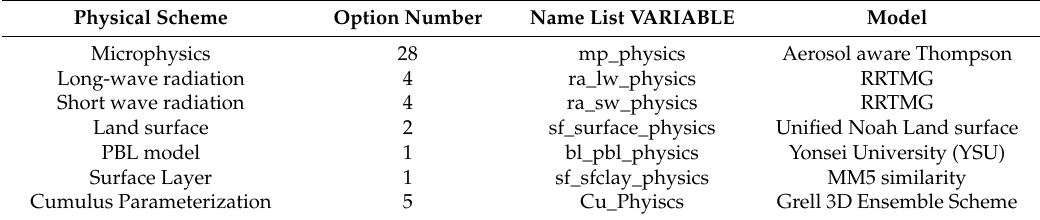
Table 1. Configuration of physical parameterization in model (Weather Research and Forecasting (WRF)) name